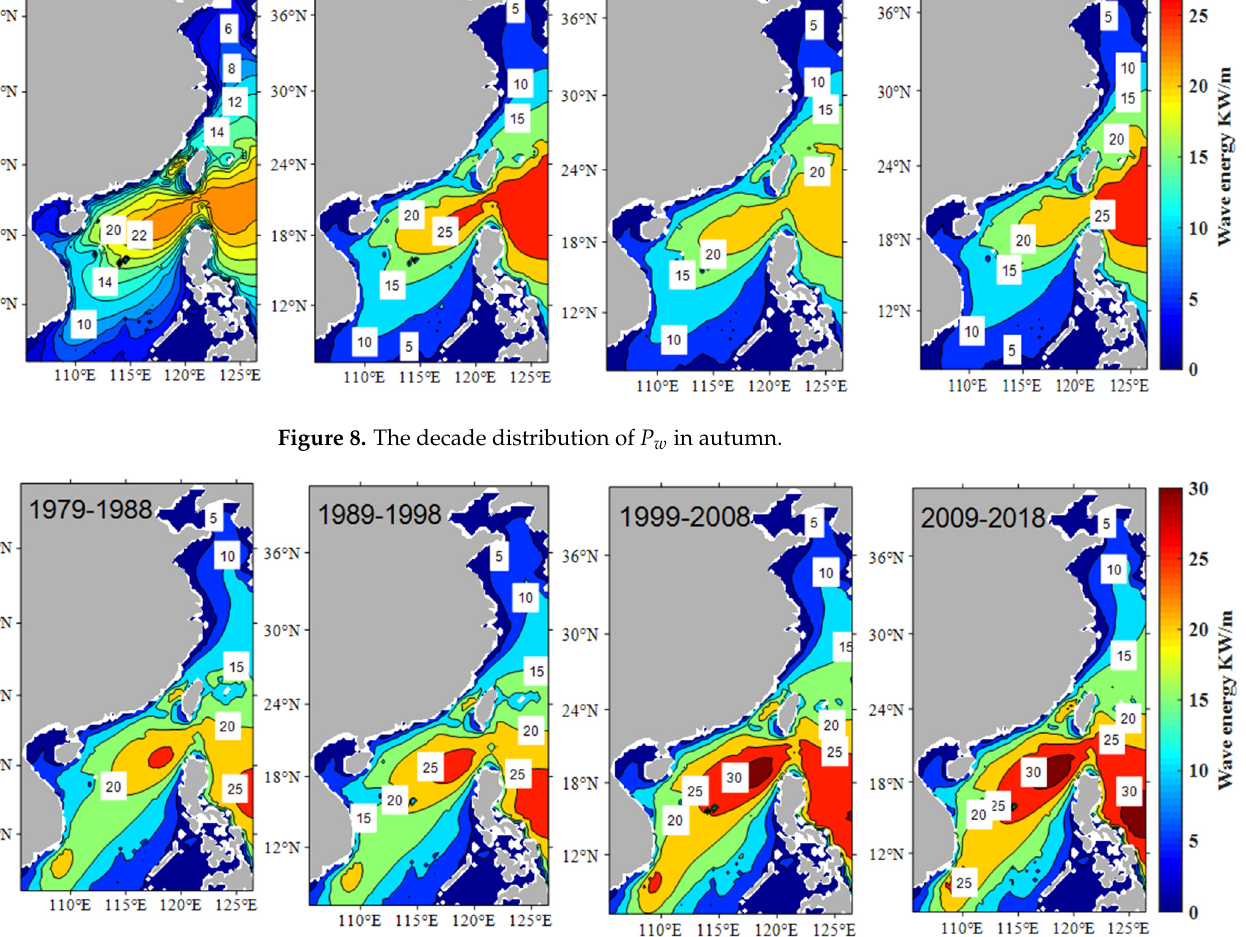
Figure 9. The decade distribution of P w in winter.